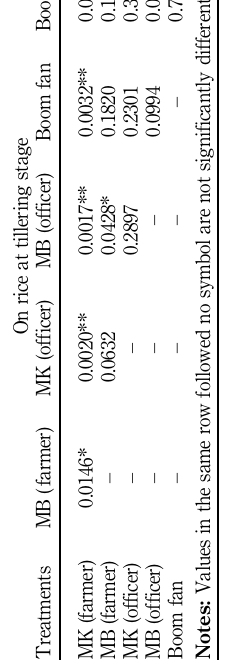
Table IV. Statistical analysis of the difference among